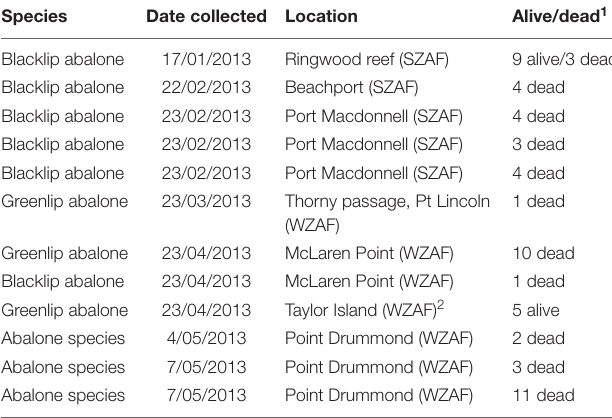
TABLE 4 | Blacklip ( Haliotis rubra ) and Greenlip ( Haliotis laevigata ) abalone samples submitted to the laboratory, which were collected by fishers that reported mortalities or by government (SARDI) staff during site